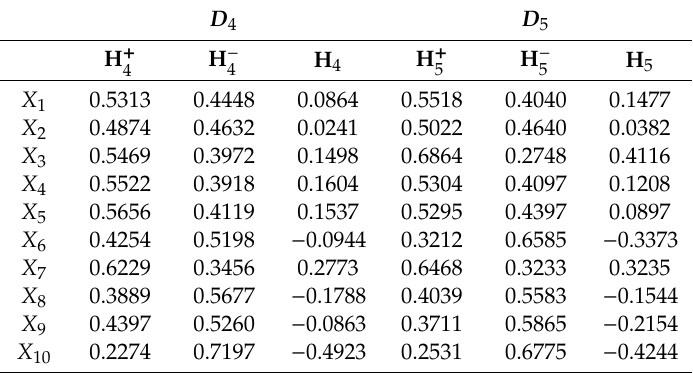
Table A16. The positive, negative and net flow of X v for D 4 , D 5 based on